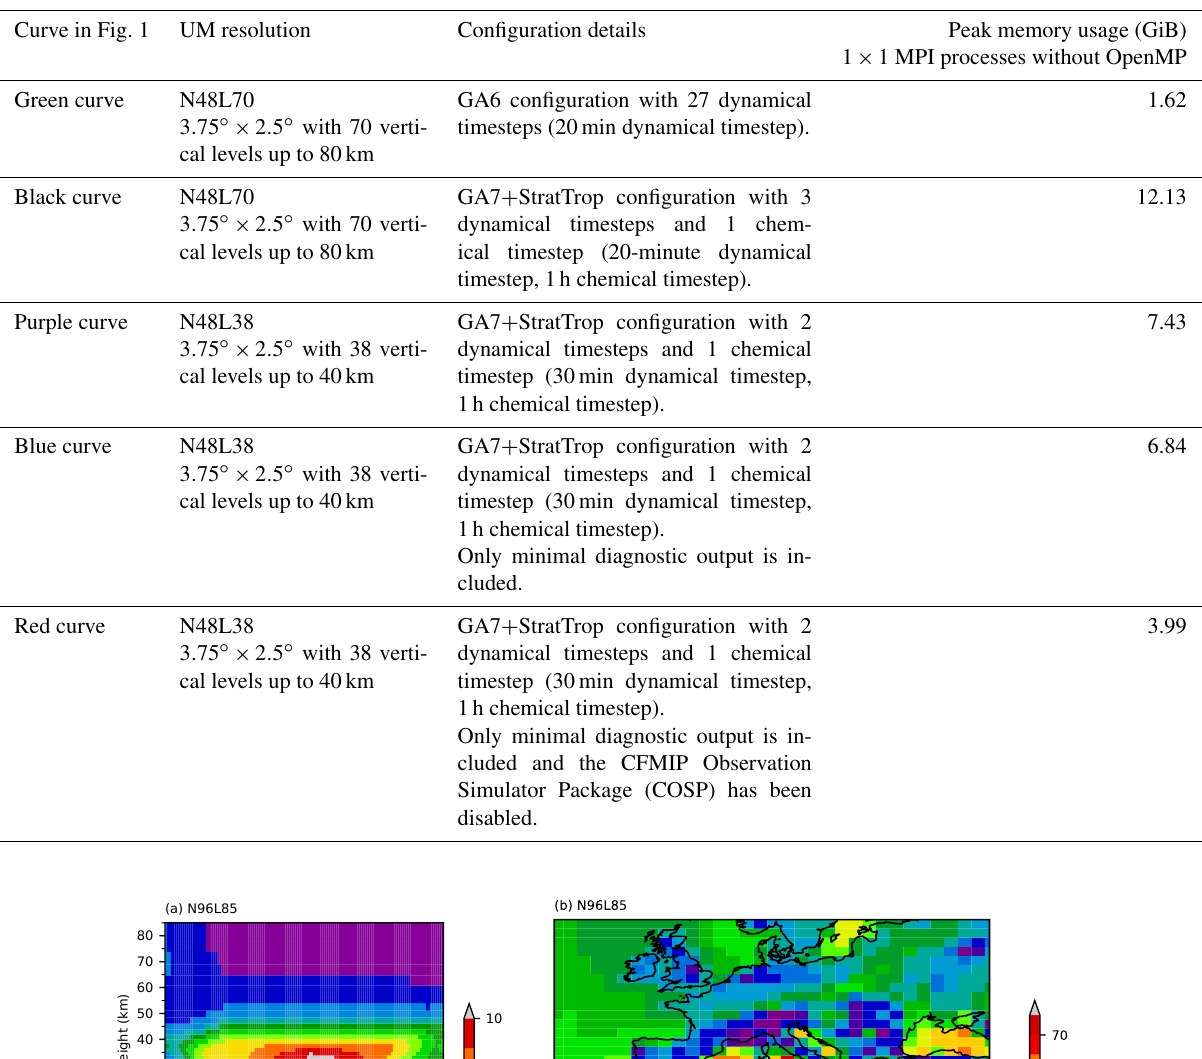
Table 1. Description of the curves presented in Fig. 1. Curve in Fig. 1